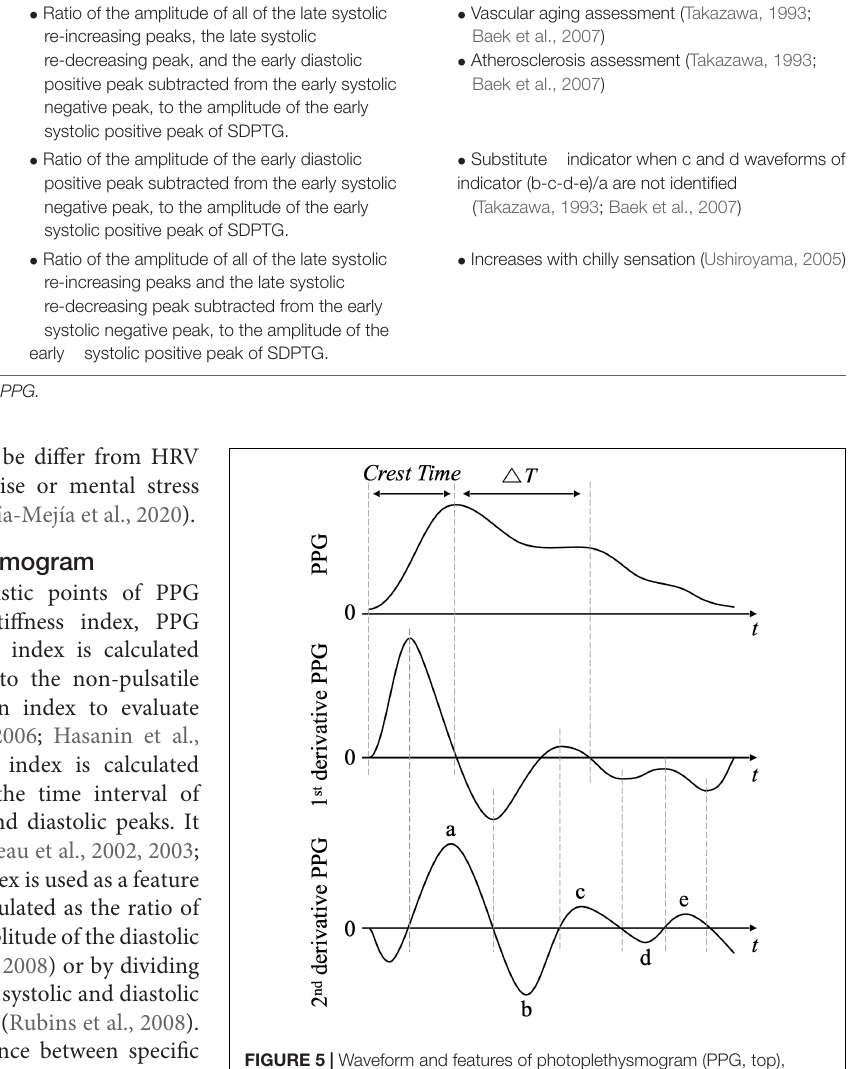
FIGURE 5 | Waveform and features of photoplethysmogram (PPG, top), derivative PPG (middle), and second derivative PPG (bottom). Crest time is the elapsed time from pulse onset to systolic peak. (cid:49) T is the time interval between systolic peak and diastolic peak that is defined by the second downward zero-crossing time in derivative PPG. In the second derivative PPG, a, b, c, d, and e are the early systolic positive peak, early systolic negative peak, late systolic re-increasing peak, late systolic re-decreasing peak, and early diastolic positive peak,